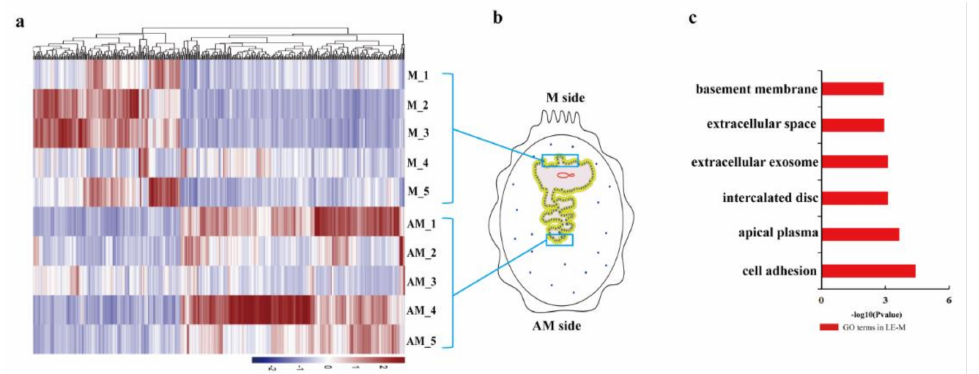
Figure 2. Heatmap and GO analysis for DEGs identified between LE-M and LE-AM on gd12 in pigs. ( a ) Heatmap for DEGs identified in LE-M compared to LE-AM on gd12. ( b ) Schematic illustration of the whole pig uterine cross-section taken from gestational day 12. ( c ) GO analysis of the upregulated DEGs identified in LE-M compared to LE-AM on gd12. DEGs: differentially expressed genes; LE-M: endometrial luminal epithelium at the mesometrial side; LE-AM: endometrial luminal epithelium at the anti-mesometrial side; gd12: gestational day 12 (pre-attachment stage).